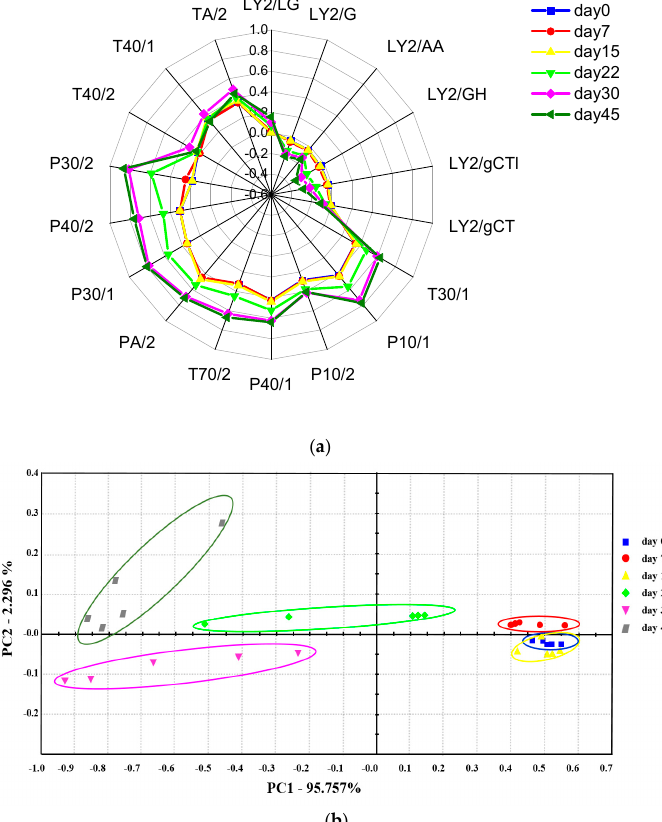
Figure 1. Results of radar plots and PCA of e-nose: ( a ) Radar plots of the mean responses of the sensors at different storage, each value represents the average score by five parallels with three replications. ( b ) Score plot using PCA analysis for discriminating bacon groups for different storage times at 4 °C. All 18 metal sensors were used as the inputs of PCA, PC1 and PC2 accounted for 95.7% and 2.3% of the variation, respectively. Each ellipse represents distances that are statistically equidistant from the group.